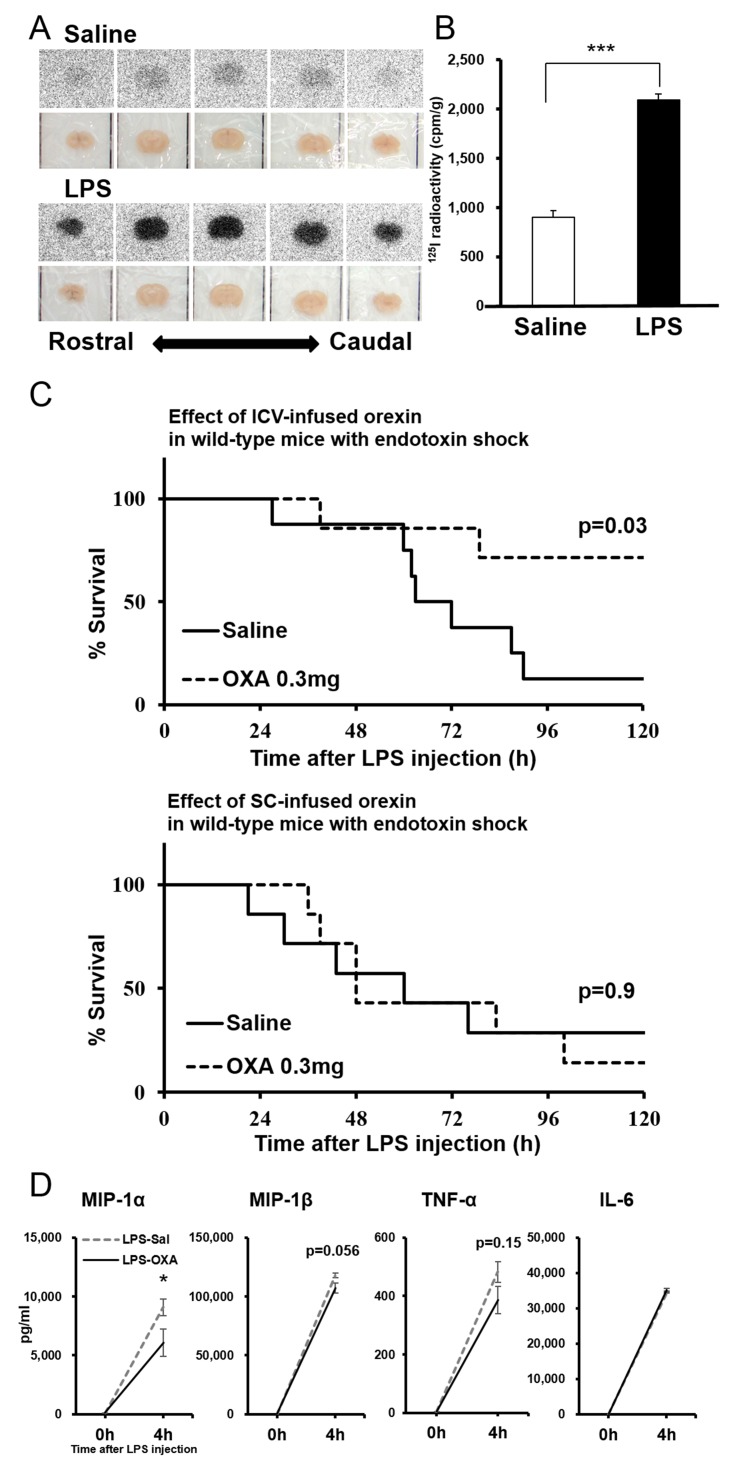
Direct action of OXA on the CNS in mice with endotoxin shock.(A) [125I]OXA-autoradiography of 1 mm coronal brain sections from control (saline) and endotoxin shock (LPS) mice. The brains were removed without perfusion at 2 hr after intraperitoneal (IP) administration of [125I]OXA, and were fixed in 4% PFA overnight. The sections were exposed to imaging plates for five days, and then scanned by BAS-2500 (Fuji Film). (B) The levels of radioactivity in the whole brain from LPS- or saline-injected mice at 2 hr after IP administration of [125I]OXA (each group n = 4, ***p<0.001). (C) Kaplan-Meier survival curves of wild-type mice intracerebroventricularly (ICV, upper; saline: n = 8, OXA: n = 7) or subcutaneously (SC, lower; each group n = 7) administered with saline or OXA (0.3 mg/mouse/24 hr) before LPS injection. (D) Effects of ICV-administered OXA on the levels of MIP-1α, MIP-1β, TNF-α and IL-6 in serum at 4 hr after LPS injection (LPS-OXA), compared to saline treatment (LPS-Sal) (each group n = 8, *p<0.05). OXA administration (0.1 mg/mouse/4 hr) started 30 min before LPS injection. Data are presented as mean±s.e.m. Statistical significance assessed by unpaired t-test (B), Mantel Cox log-rank test (C), and 2-way ANOVA coupled with the Bonferroni’s test (D). Data are replicated in at least three independent experiments.